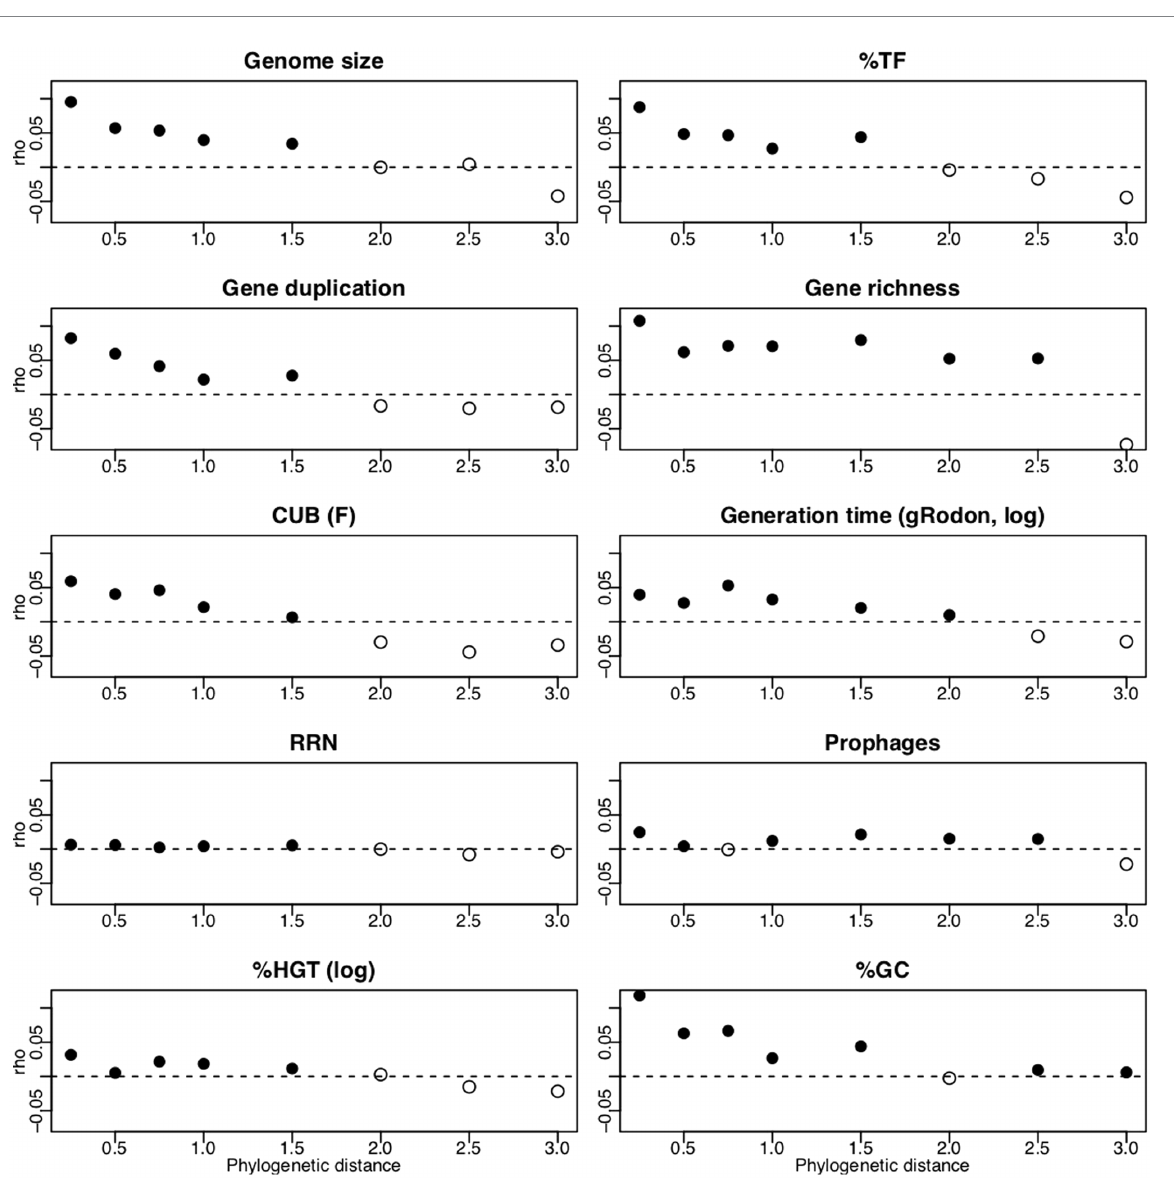
FIGURE 7 Results from Mantel correlograms. Filled data points indicate positive significant correlations (Bonferroni adjusted value of p s Padj <0.1) of pairwise distances of traits values against pairwise phylogenetic distances among the reference genomes. The Mantel correlograms were computed for 10,000 randomly selected genomes and with 200 permutations. In the specific case of RRN we computed the Mantel correlogram based on trait values of the rrnDB, while for all other traits JGI/IMG trait values as reported in the Supplementary Table S1 were used (%HGT was log(x + 0.001) transformed and Generation time was log(x) transformed). We inferred the RRN rrnDB phylogenetic signal from a phylogenetic tree calculated using rrndbDB 16s rRNA gene sequences (FastTree 2, Price et al., 2010) and using the trait values available via the rrnDB (https://rrndb.umms.med. umich.edu/static/download/, rrnDB-5.7). The phylogeny for all JGI/IMG values was inferred using the pro_ref.tre phylogenetic tree, which is used as backbone phylogeny of the PICRUSt2 software. All analyzes to compute Mantel correlograms were performed in R (R Core Team, 2021). Scripts with the code for all analyzes described in this figure legend are available on GitHub